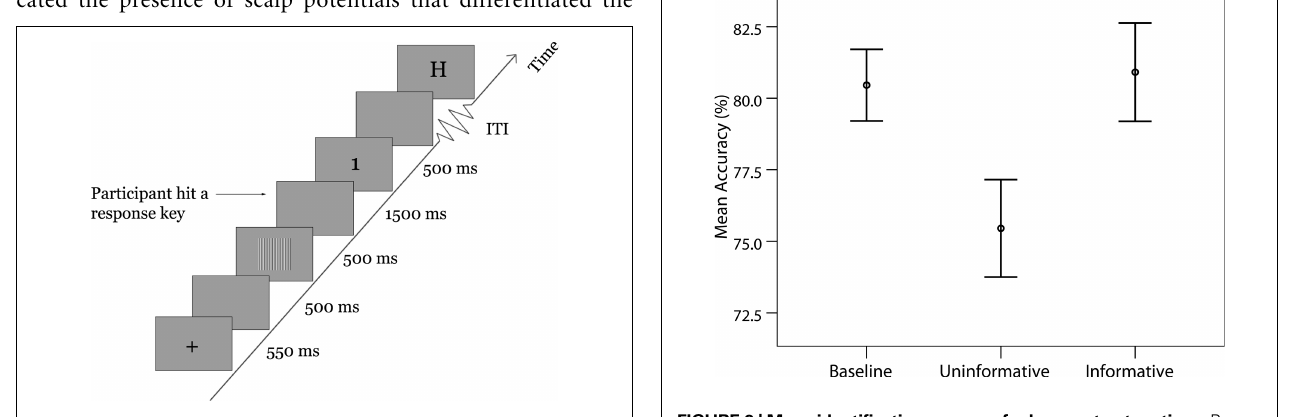
FIGURE 1 | Task schematic.